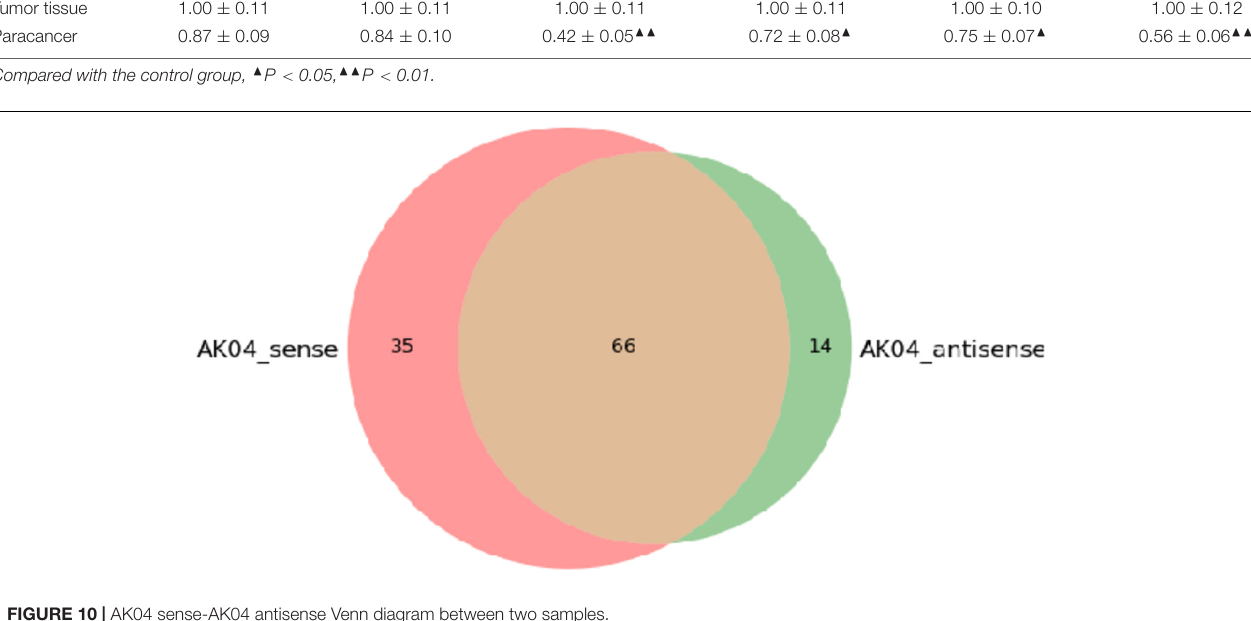
the sequence is displayed in green and its credibility is above 95%, and the credibility of the yellow is 50 ∼ 95% (can be Reference), the credibility of red is 0– 50% (uncredible), and the ones shown in gray can be But if the sequence is at the -COOH end, even if it is gray, it is not necessarily wrong, because